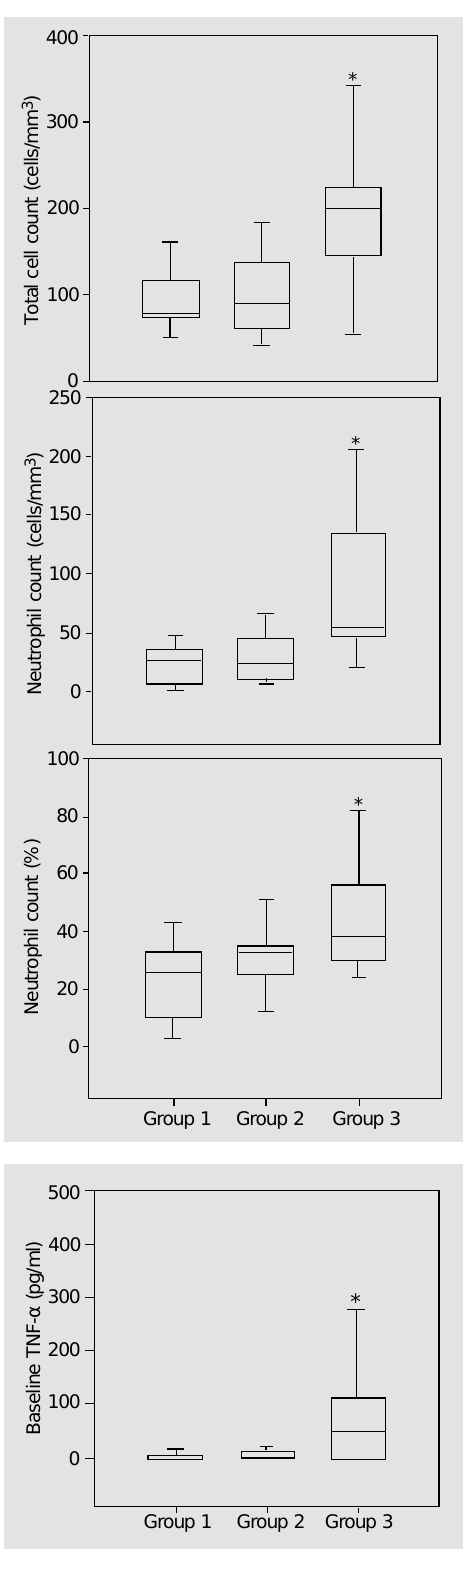
Figure 3. Baseline TNF- α levels in the three groups. After 4 h, the baseline TNF- α was higher in group 3 (V T = 42 ml/kg) com- pared with group 1 (V T = 21 ml/ kg) and group 2 (V T = 7 ml/kg). *P<0.05 (one-way rank analysis of